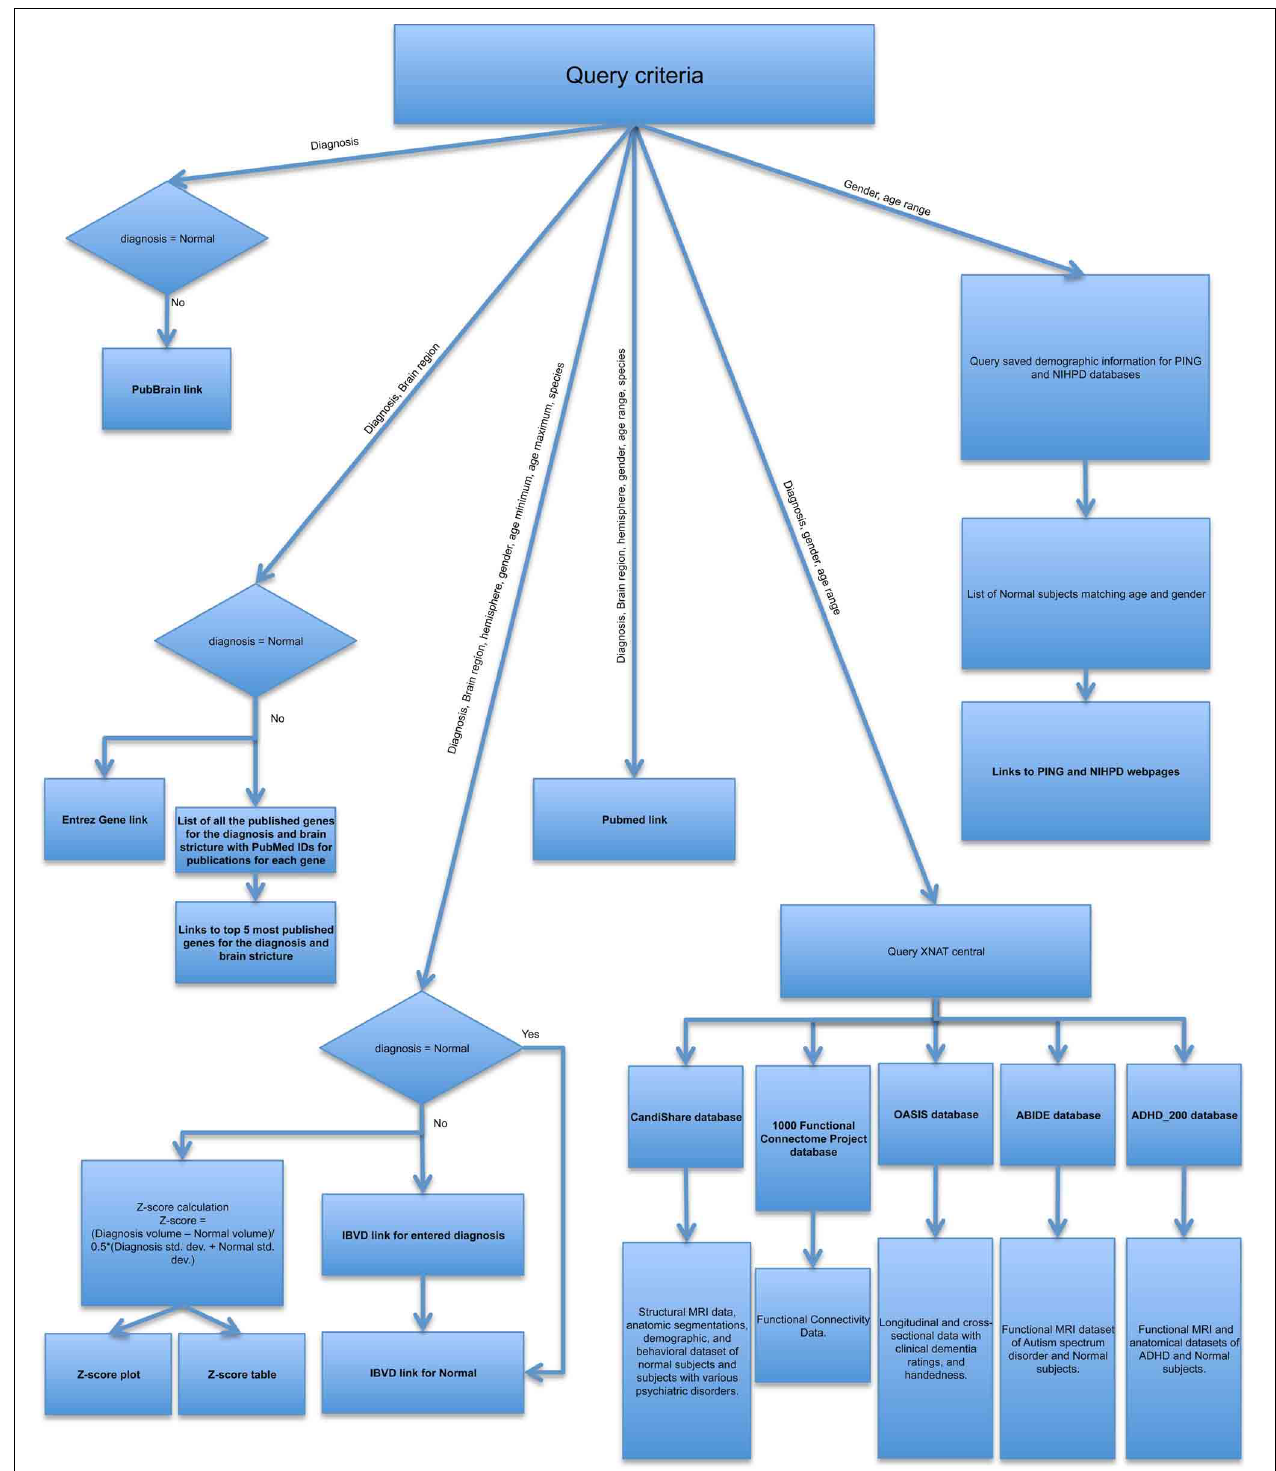
FIGURE 2 | Flowchart depicting how the query input is tailored to requirements of various